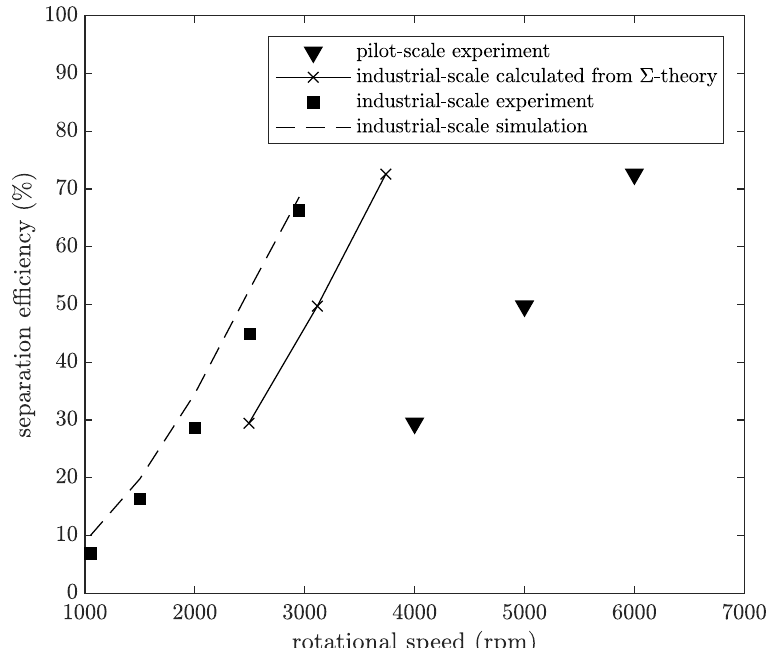
Figure 10. Comparison of scale-up via Σ -theory, and simulation from pilot-scale to industrial-scale for